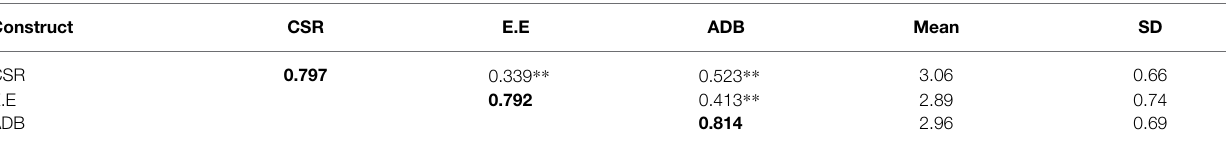
TABLE 5 | Correlations and discriminant validity.